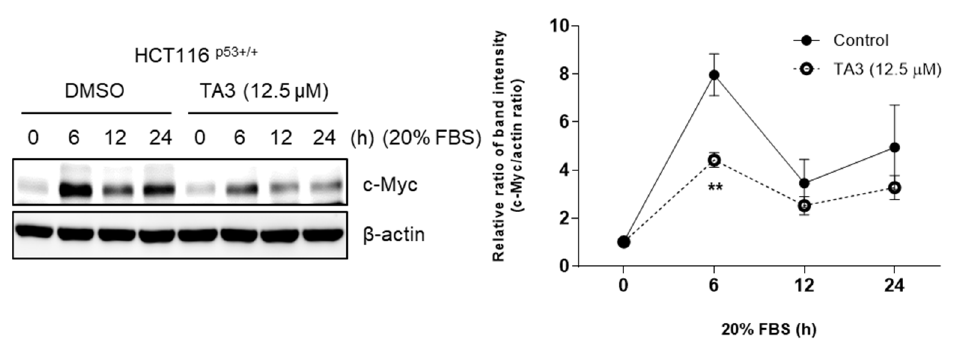
Figure 4. TA3 regulates c-Myc expression by serum stimulation. Cells were treated with TA3 (12.5 μM) and were starved in 0.2% FBS for 24 h and stimulated with 20% FBS for indicated time points. p -values indicate significant differences between the groups. Statistical significance was analyzed using the unpaired t-test. Quantification of protein expression is shown in the right panel. ** p < 0.005 vs. control.